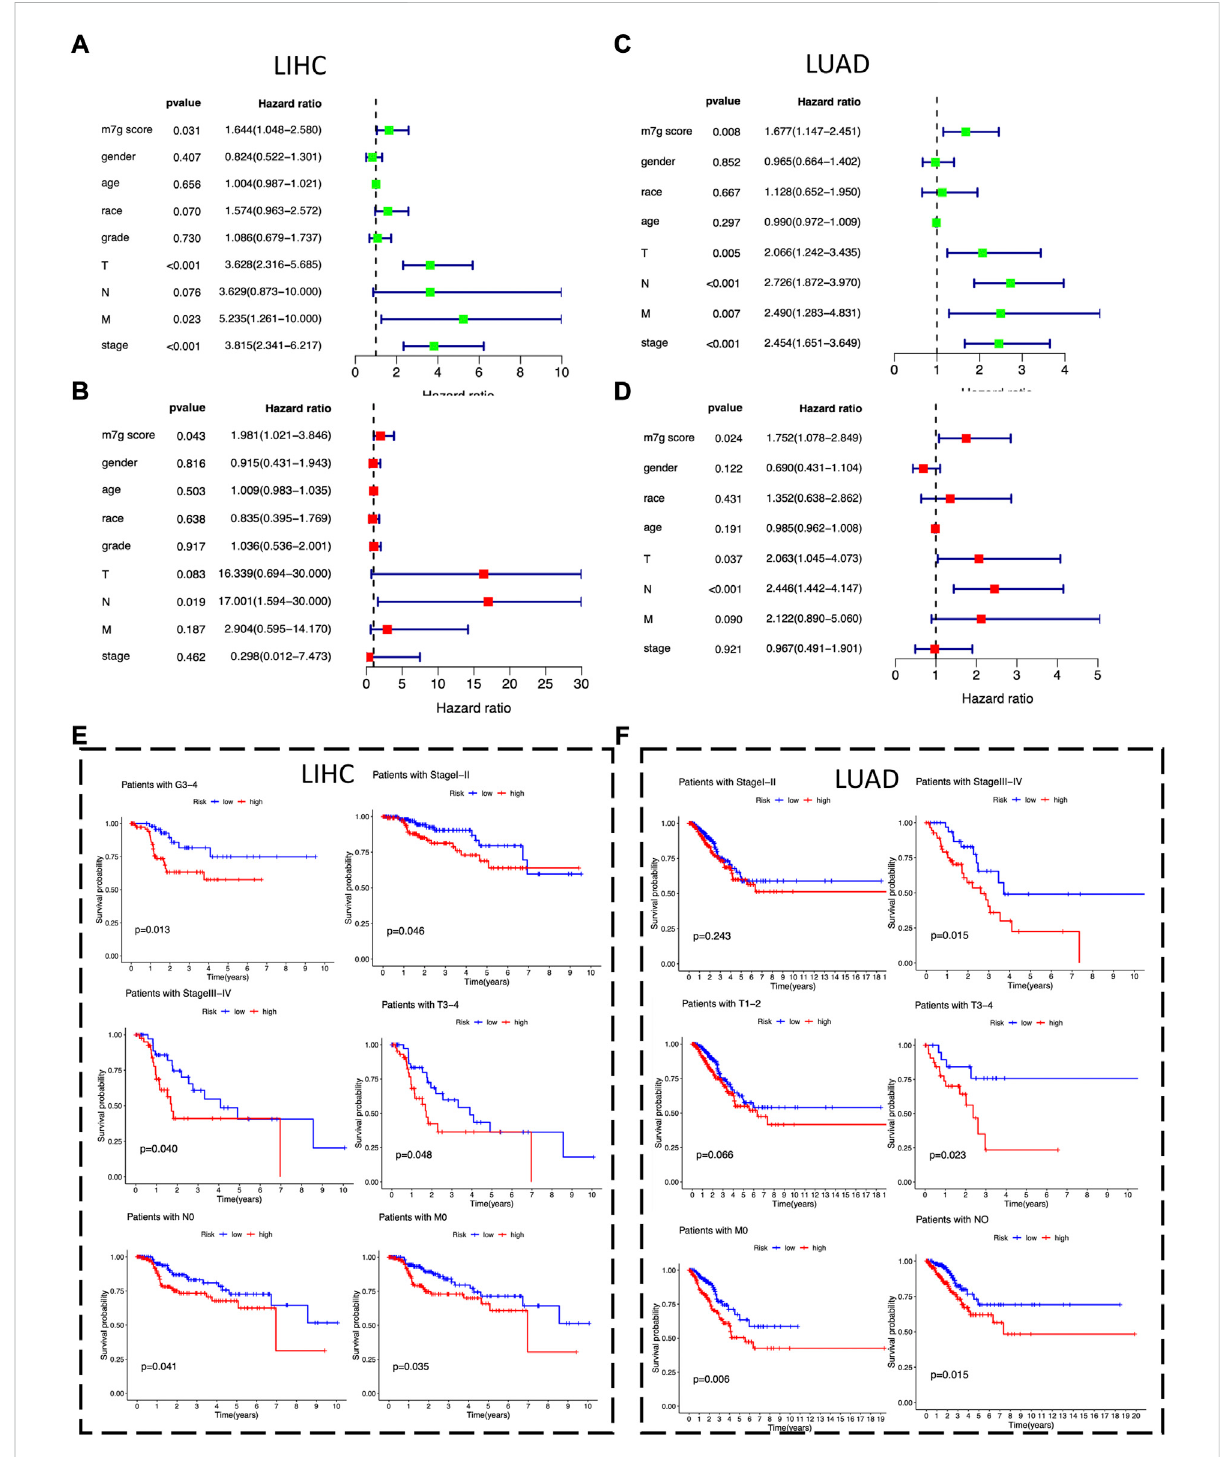
FIGURE 6 The m7Gscore is an independent prognostic factor in LIHC and LUAD. (A) Univariate Cox regression analysis of m7Gscore and main clinicopathologic features associated with DSS in LIHC. (B) Multivariate analysis of m7Gscore and main clinicopathologic features associated with DSS in LIHC. (C) Univariate Cox regression analysis of m7Gscore and main clinicopathologic features associated with DSS in LUAD. (D) Multivariate analysis of m7Gscore and main clinicopathologic features associated with DSS in LUAD. (E) Kaplan-Meier survival analysis of DSS strati fi ed by main clinicopathologic features in LIHC. (F) Kaplan-Meier survival analysis of DSS strati fi ed by main clinicopathologic features in